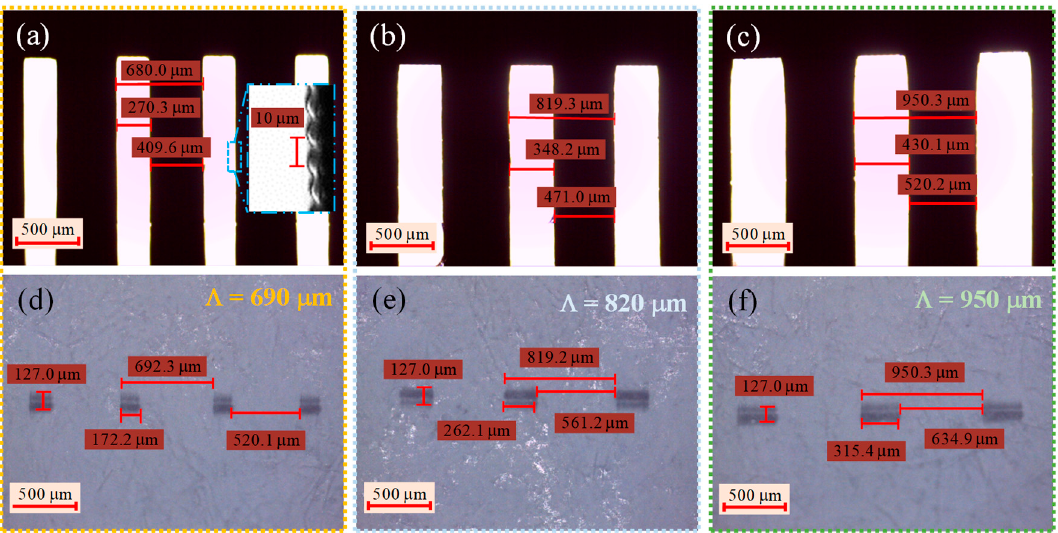
Figure 5. Microscope images of the amplitude masks ( a – c ), and the UV pattern imprinted in a thermal paper using those masks ( d – f ). Top images correspond to the periods of: 690 µm ( a , d ), middle images to the 820 µm ( b , e ), and bottom images to the 950 µm ( c , f ).